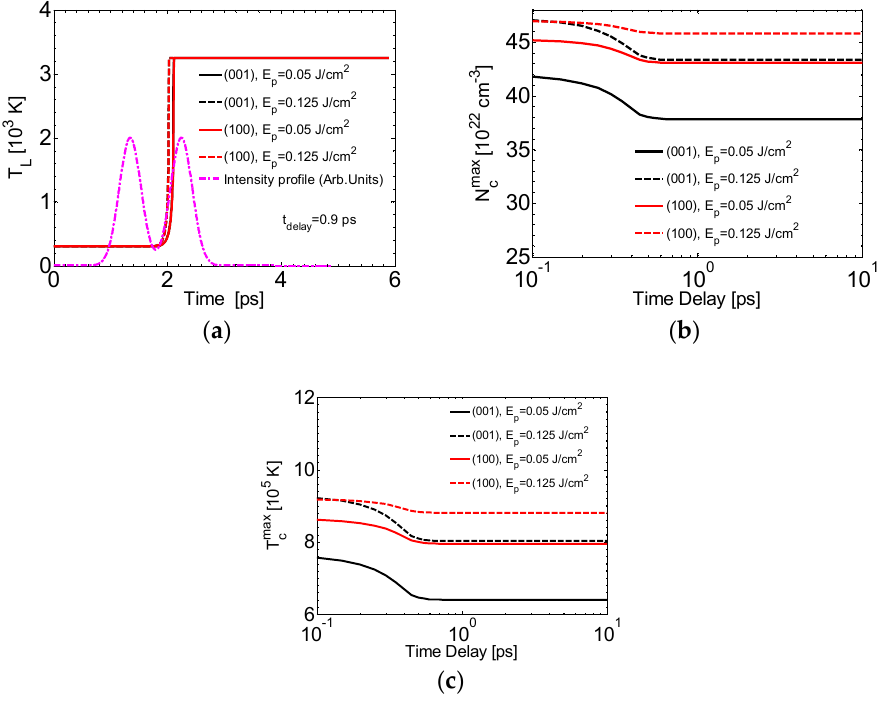
Figure 5. Evolution of carrier temperature for E p = 50 mJ/cm 2 and 125 mJ/cm 2 for (001) and (100) crystal orientation at t delay = 0.5 ps ( a ), 0.9 ps ( b ), and 1.5 ps ( c ).